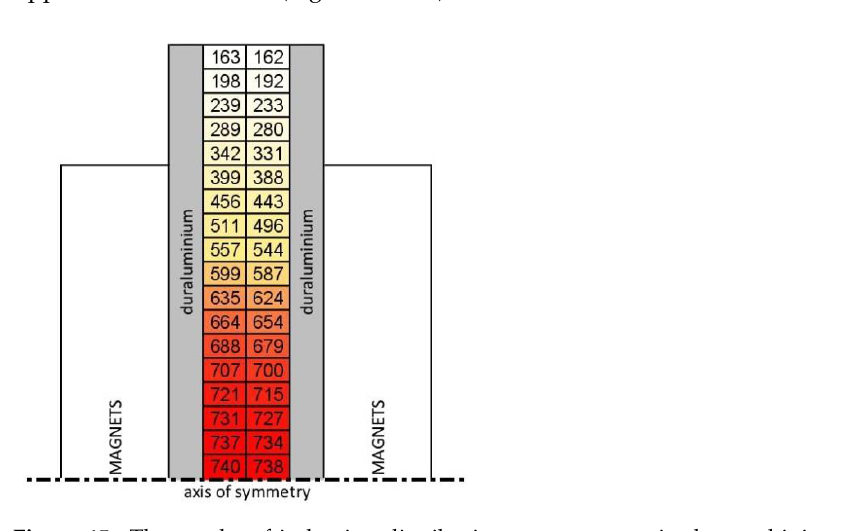
Figure 15. The results of induction distribution measurement in the machining gap [×10 −3 T]. The distance between magnets amounts to 23 mm.